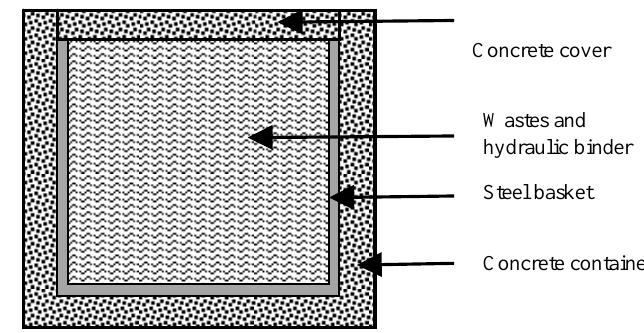
Fig. 1. Schematic representation of the concrete